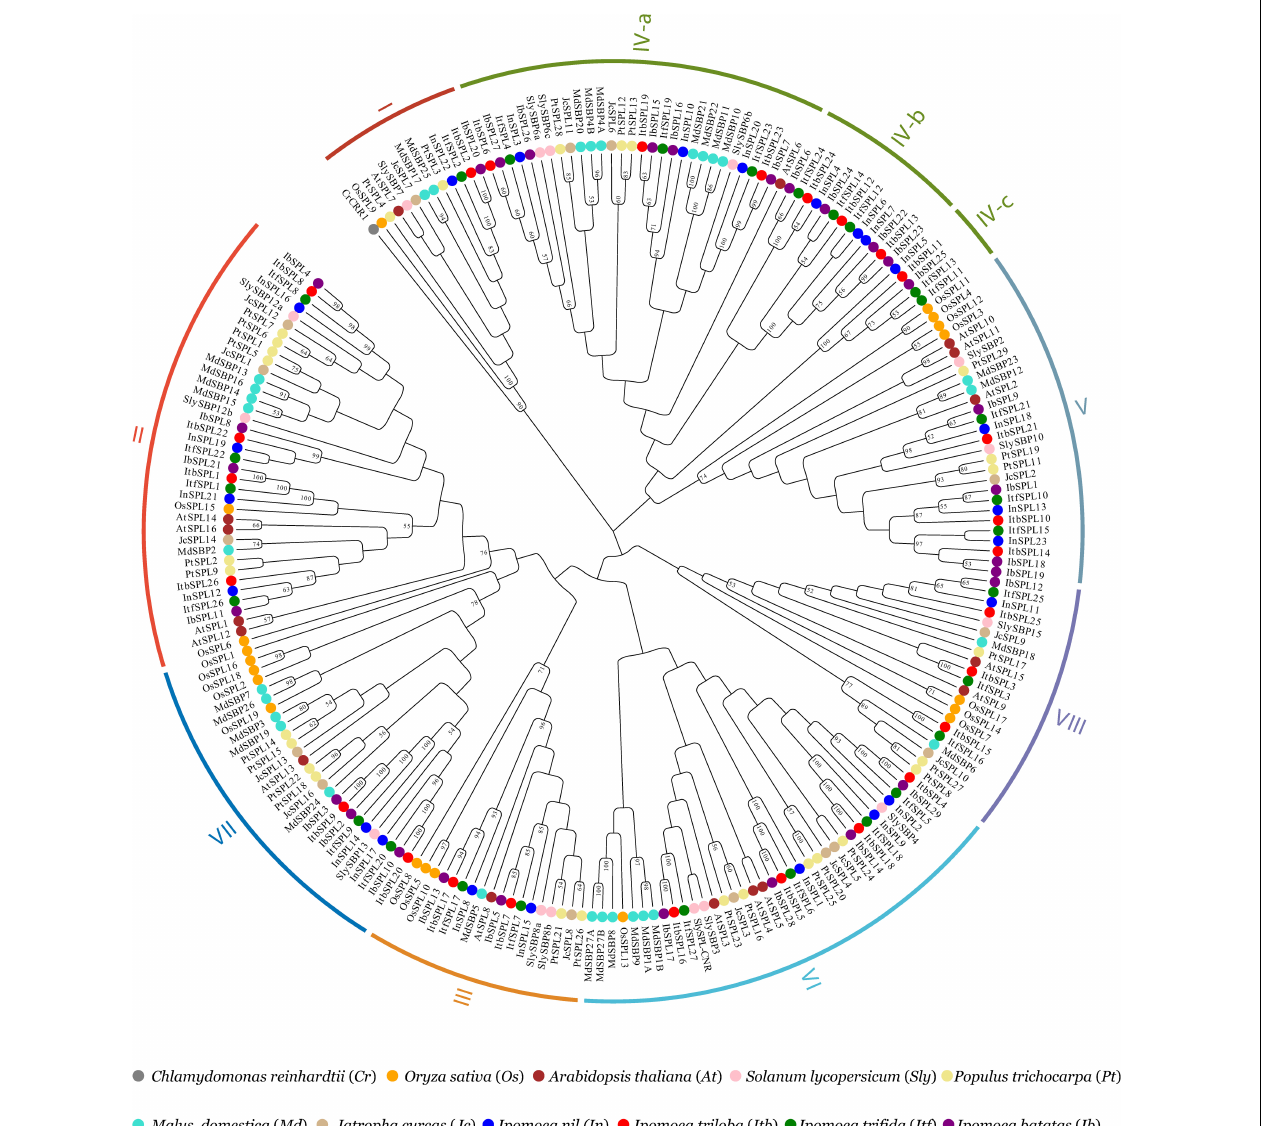
FIGURE 2 | Phylogenetic analysis of SPL proteins from I. batatas , I. trifida , I. triloba , I. nil , C. reinhardtii , A. thaliana , J. curcas , M. domestica , P. trichocarpa , S. lycopersicum , and O. sativa. The rooted phylogenetic tree was constructed based on the conserved domain of 229 SPLs using the neighbor-joining method with 1000 bootstrap replications. The CrCRR1 protein from C. reinhardtii was used as an outgroup to root the tree. Numbers on the tree indicate bootstrap support (values < 50% not shown). Each colored arcs indicates the different clades of the SPLs. SPL members from the same species are marked with the same colors: Blue, I. nil ; red, I. triloba ; green, I. trifida ; purple, I. batatas ; gray, C. reinhardtii ; orange, O. sativa ; brown, A. thaliana ; pink, S. lycopersicum ; tan, J. curcas ; turquoise, M. domestica ; khaki, P. trichocarpa